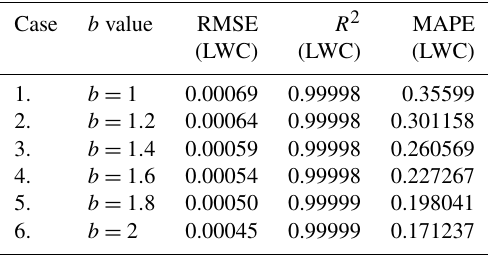
Table 9. Error in retrieved LWC for different b